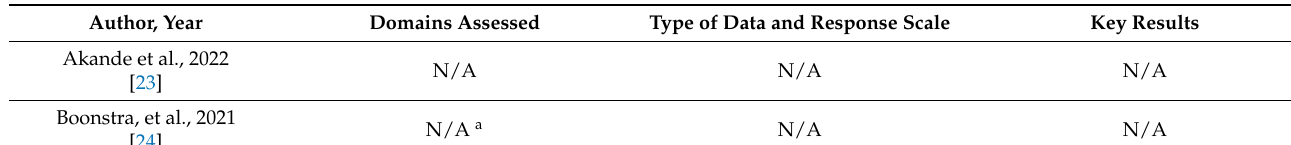
Table 4. Summary of overall acceptance or level of consumption of novel insect-enriched meal as complementary feeding for